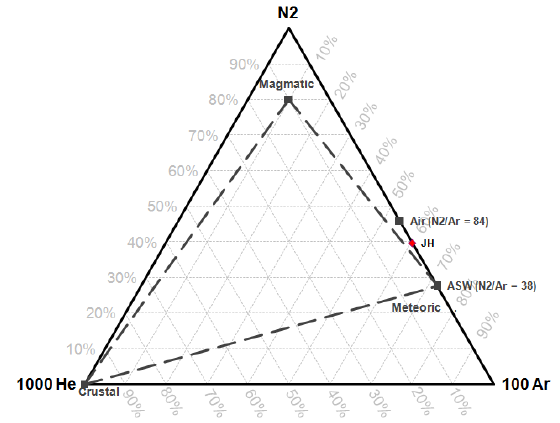
Figure 5. N 2 -He-Ar triangle diagram.